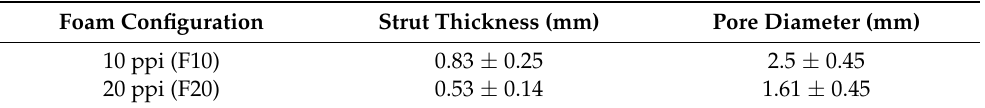
Figure 4. Optical Morphologies of the SiC foams: ( a ); 10 ppi; ( b ) 20 ppi; ( c ) struts; and ( d ) triangular voids in foam. Table 5. Comparison of foam morphologies.